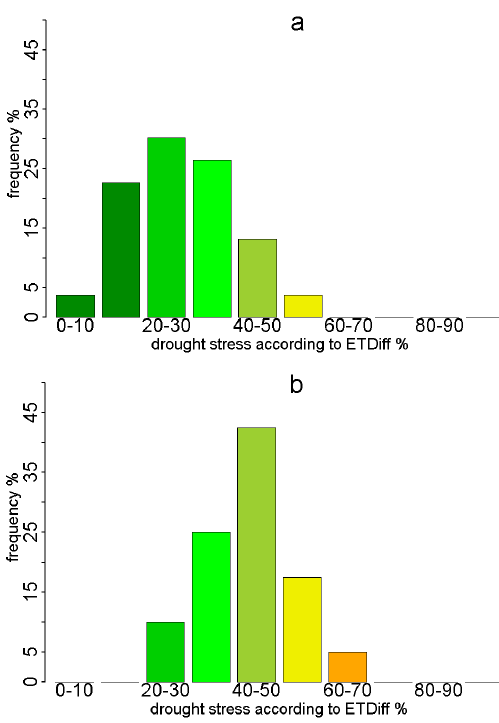
Fig. 6. Histogram of drought stress index ET Diff (threshold=4mm) for (a) : simulations with measured climate data (1951–2003) and (b) : simulations with climate projections (2061–2100, WETTREG A1B normal); even site and an available water capacity of 150mm; climate station “Deuselbach”,